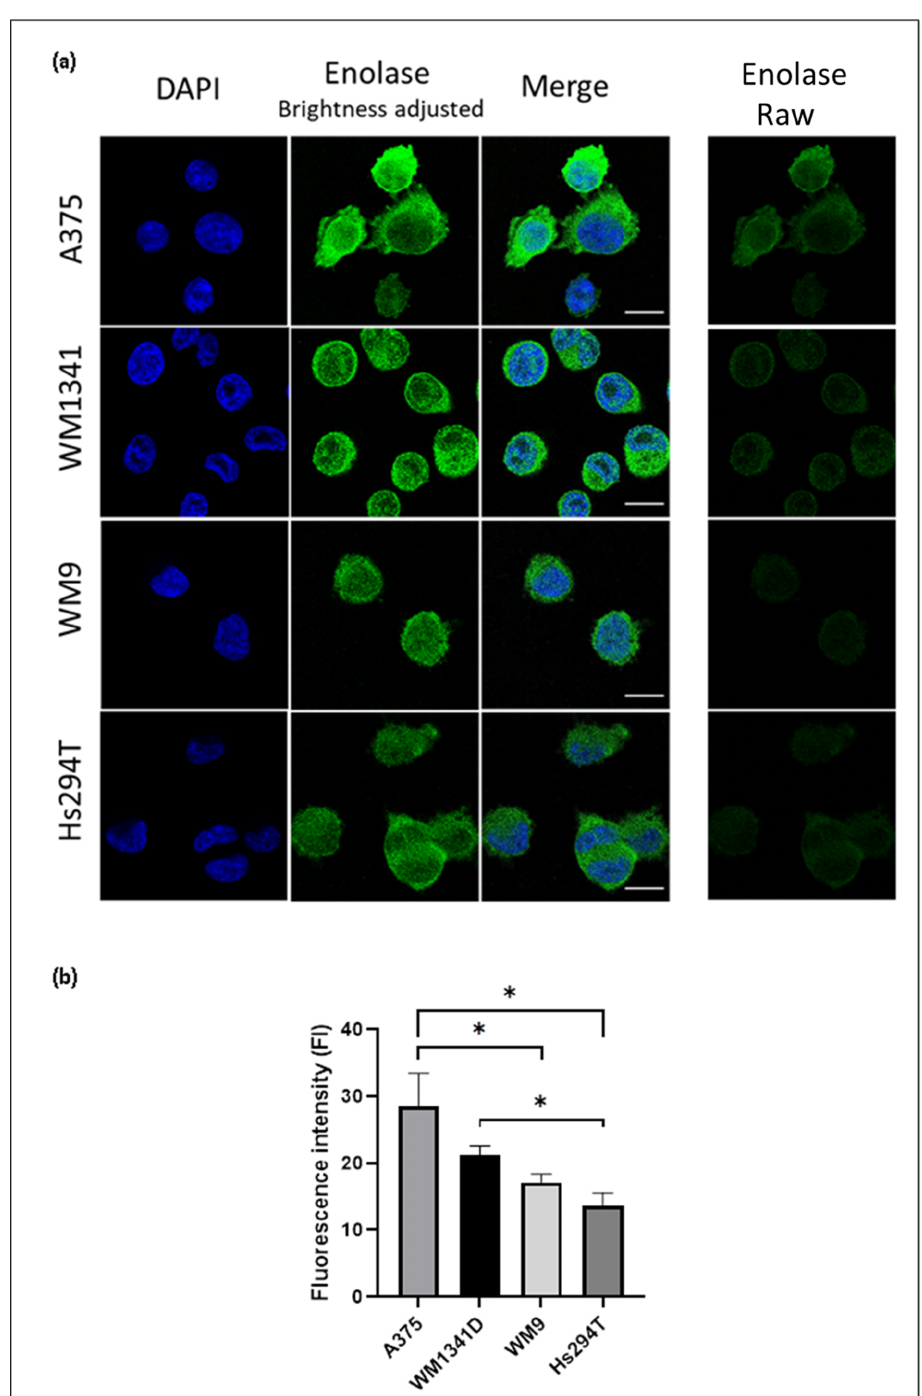
Figure 2. Enolase expression in melanoma cell lines determined by indirect immunofluorescence and confocal microscopy. ( a ) Single optical sections showing cells stained for ENO1 (green) and DAPI (blue). In the second column ENO1 signal was enhanced by brightness adjustment for the sake of better visualization. Raw images (shown in the last column) were subjected to fluorescence signal intensity analysis. Bar—15 µ m. ( b ) Fluorescence signal intensity of the ENO1 presented as a mean ± standard deviation. The significance level was set at p = 0.05–0.01 (*). Subsequent number of cells were analyzed: A375—40 cells, WM1341D—71 cells, WM9—25 cells, Hs294T—45